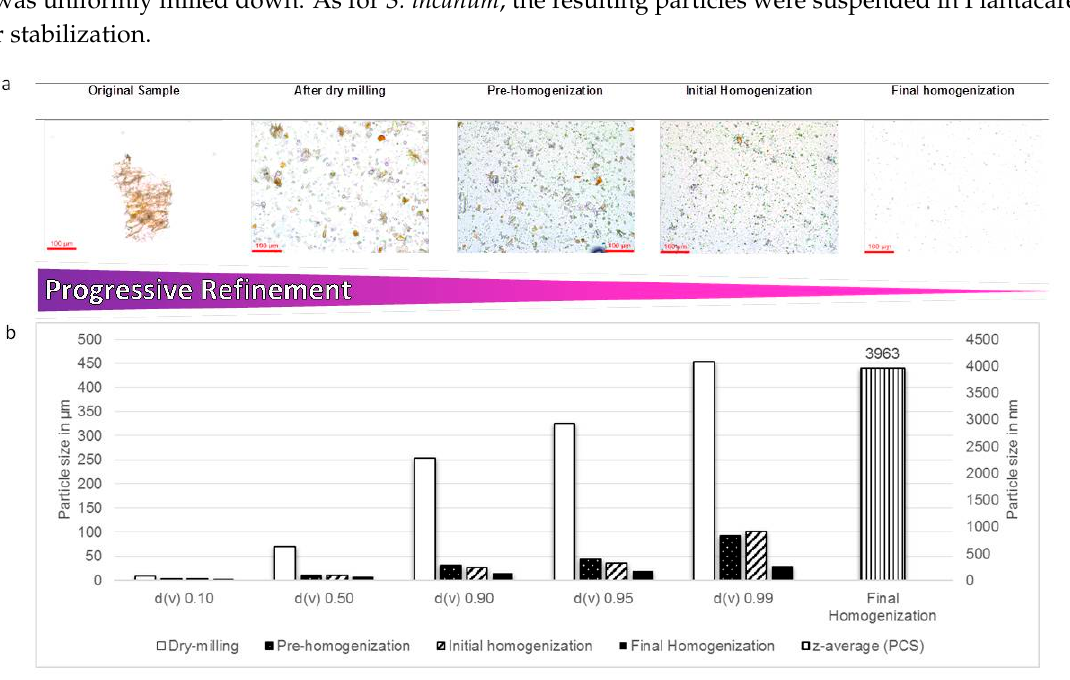
Figure 4. ( a ) Optical microscopy of sequentially processed bark of P. erinaceus , from the crude plant material ground down with a simple coffee grinder at the University of Lomé in Togo on the left to initially and finally homogenized materials on the right (200-fold magnification). ( b ) LD and PCS analysis of the different samples confirming a progressive refinement of the particles to a final average particle size of just below 4 µm achieved by HSS and subsequent HPH.